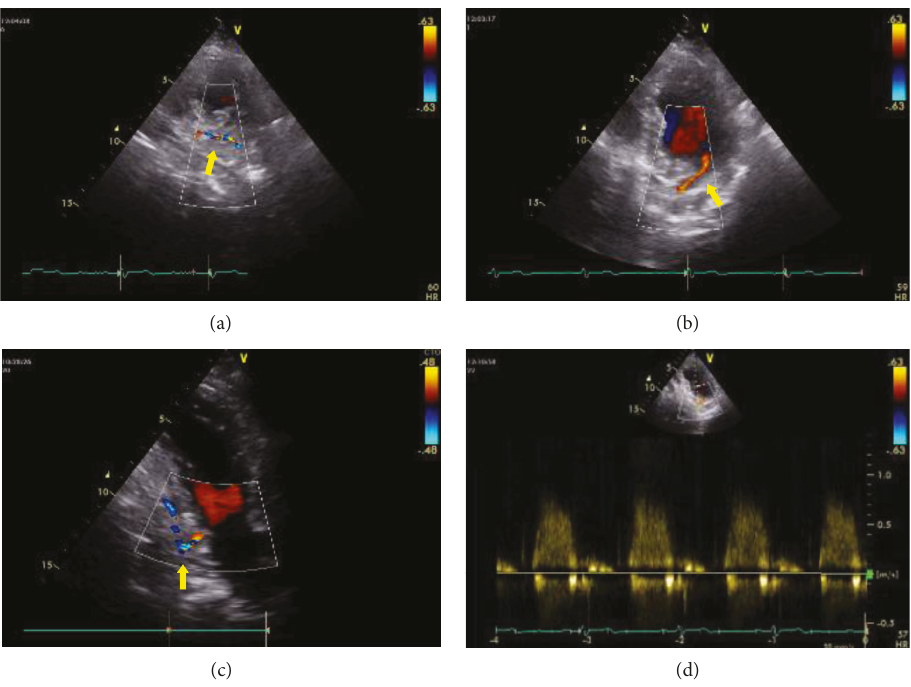
Figure 1: Midventricular (a) and basal (b) short axis view and 2-chamber (c) with color Doppler, showing fi stula ’ s course in the left ventricle inferoposterior wall (arrows). (d) PW-Doppler recording fi stula fl ow that is predominantly diastolic.